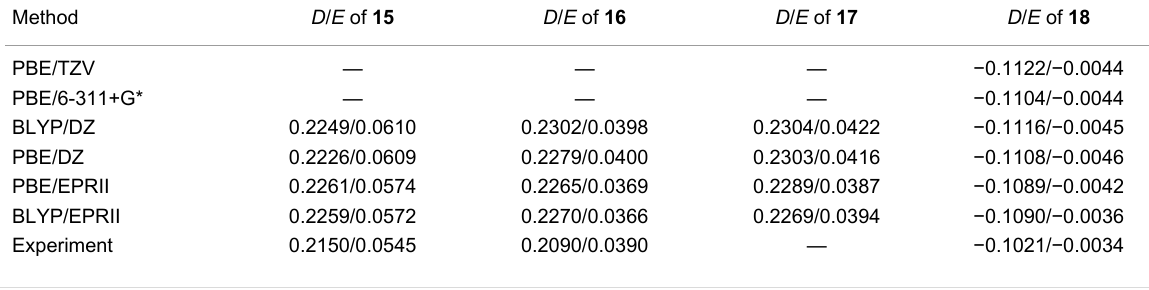
Table 2: DFT calculated and experimental parameters D / E in cm − 1 of nitrenes 15 – 18 . Method